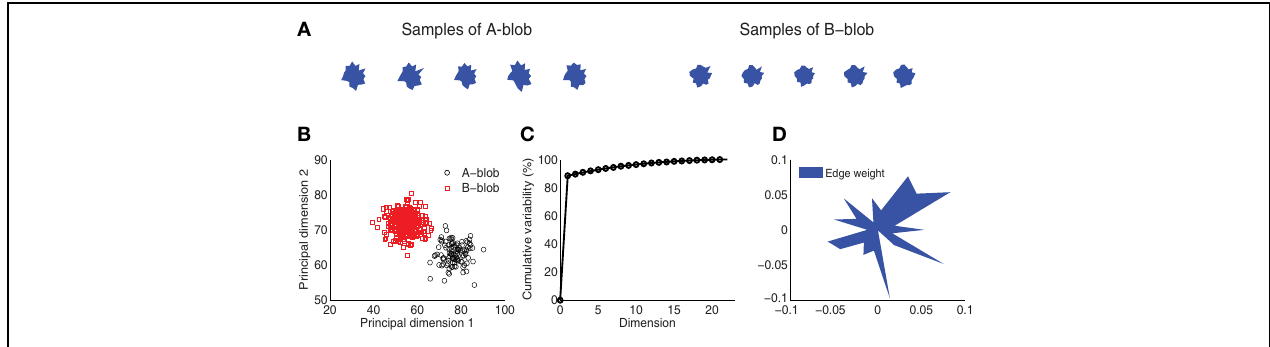
FIGURE 1 | Visual stimulus design. (A) Blob samples from A and B categories. (B) Projection of A and B blobs in two principal dimensions via principal components analysis. (C) Cumulative variability accounted for in the principal dimensions. (D) Normalized edge weights from the first principal dimension.